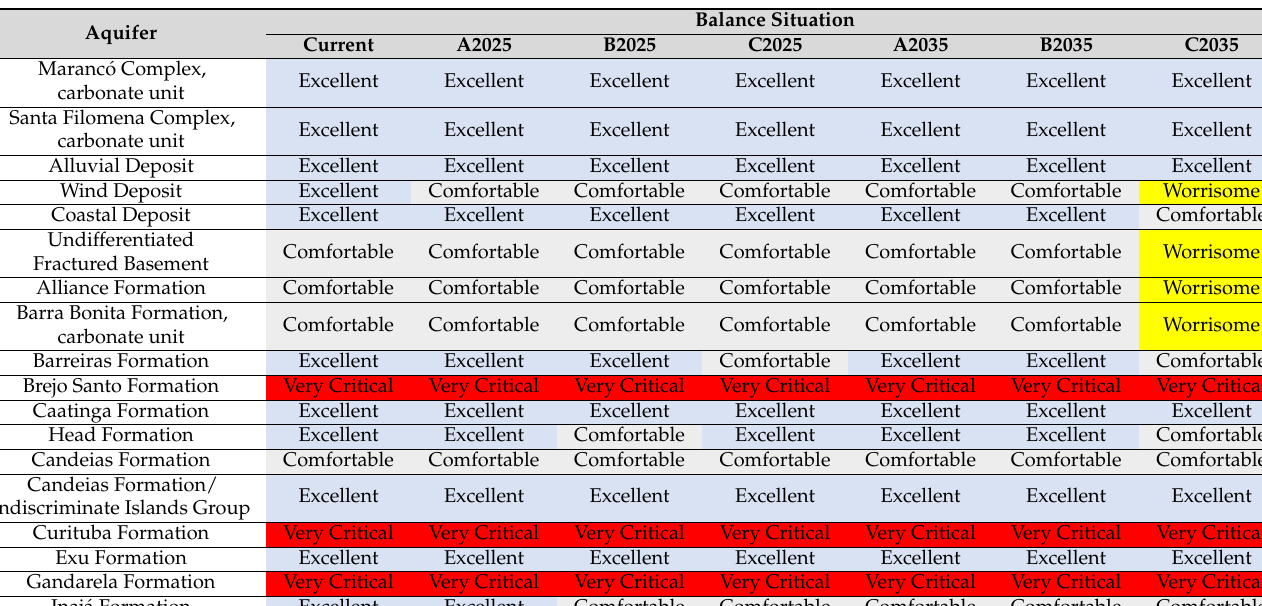
Table 13. Groundwater balance by aquifer